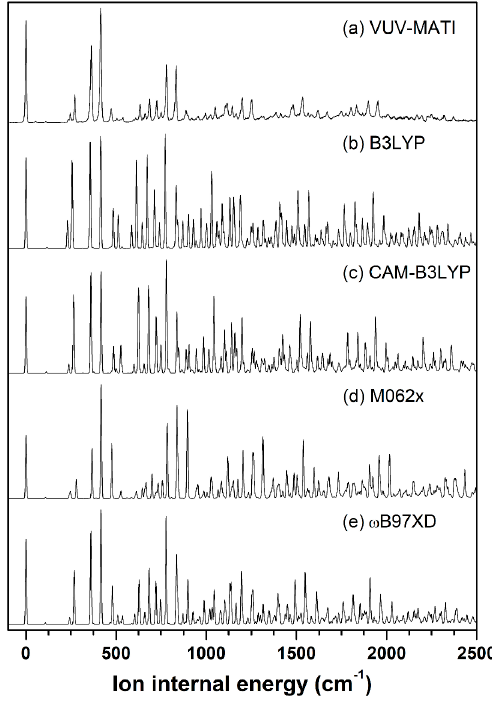
Figure 3. ( a ) HR VUV-MATI spectrum of pivaldehyde. Spectra simulated using FC factors and vibrational frequencies calculated at ( b ) B3LYP, ( c ) CAM-B3LYP, ( d ) M062X, and ( e ) ω B97XD levels with the cc-pVTZ basis set for adiabatic ionic transitions between optimized neutral and cationic pivaldehyde.